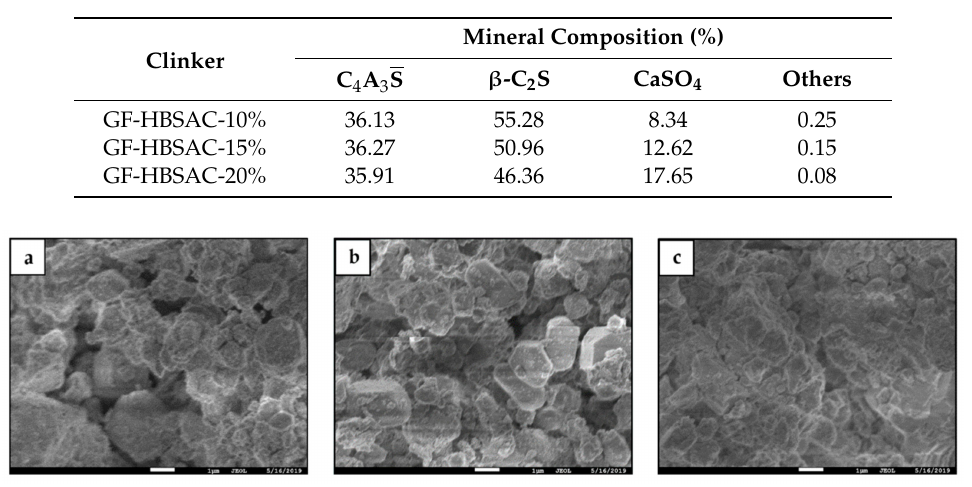
Figure 9. SEM micromorphology of the Series GF-HBSAC-Y cement: ( a ) GF-HBSAC-10%; ( b ) GF-HBSAC-15%; ( c )